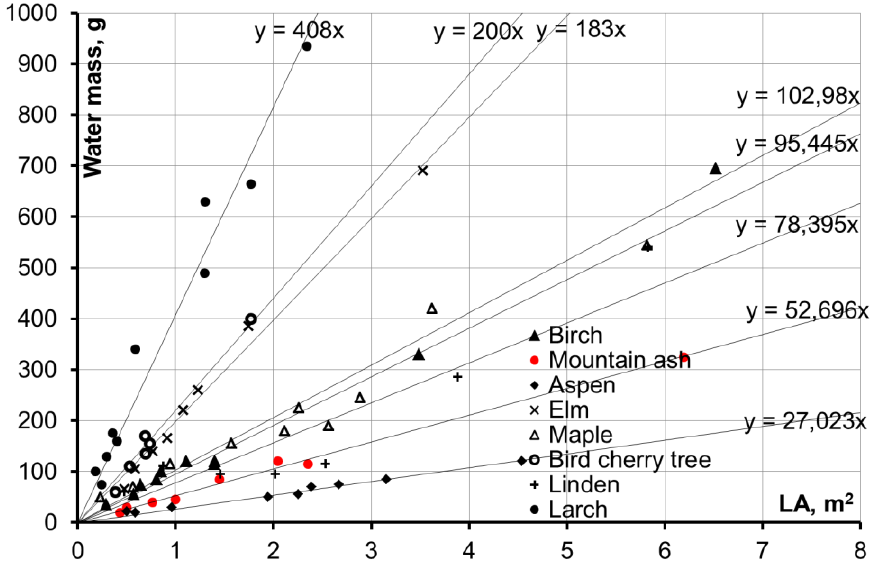
Figure 2. Dependence of the maximum weight of retained water (g) on the leaf surface area of the analyzed species ( LA , m 2 ).